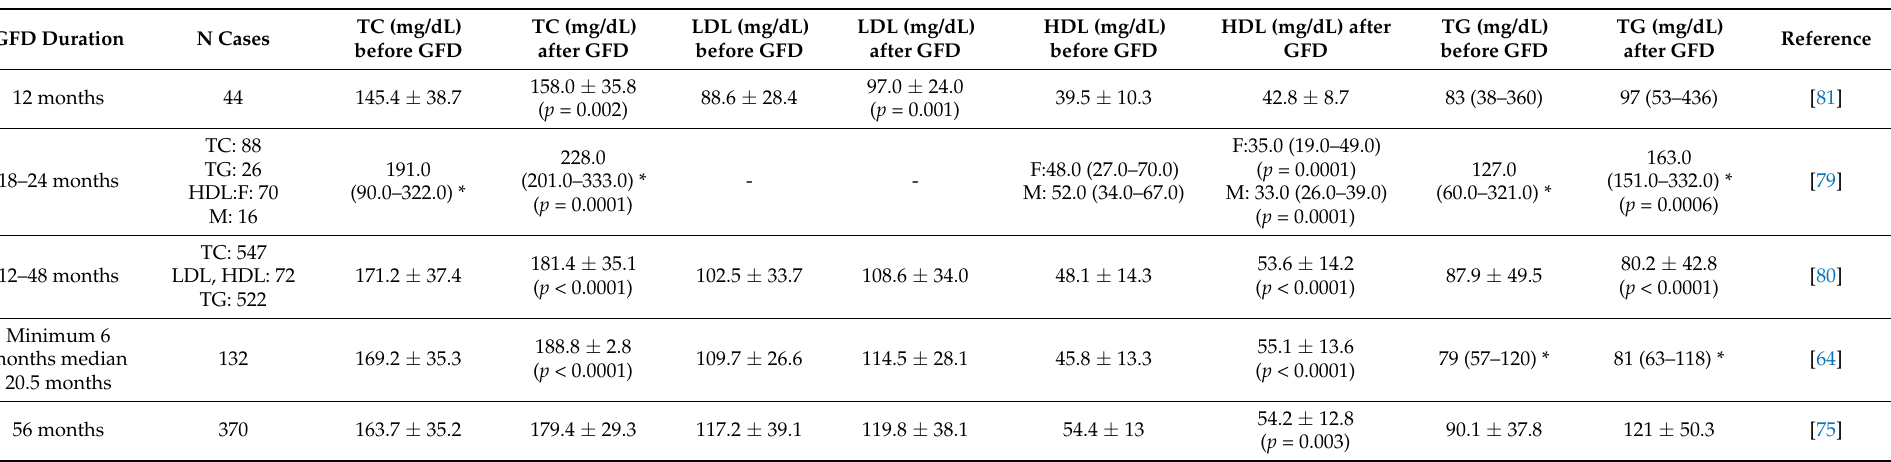
Table 2. The lipid profile ofpatients at the time of the CD diagnosis and after the introduction of a gluten-free